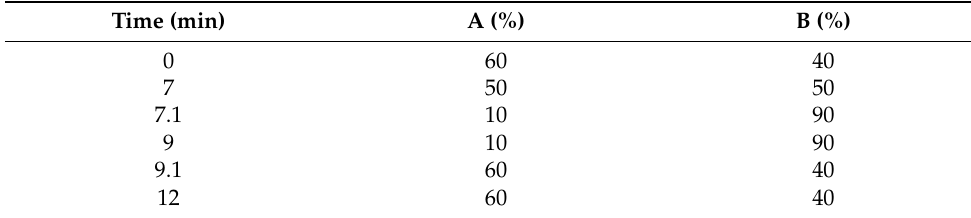
Table 1. Mobile phase gradient elution